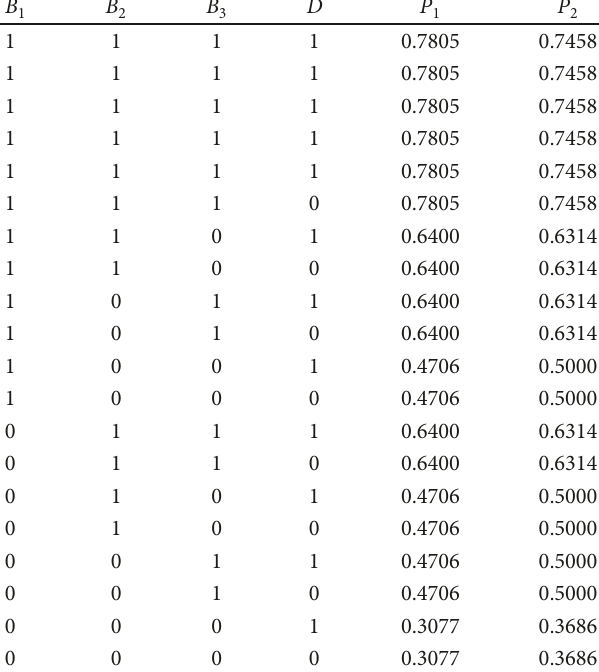
Table 2: Probabilities estimated for Schaeben and van den Boogaart ’ s [33] fabricated data set. Binary predictors B 1 , B 2 , and B 3 are the explanatory variables and D represents the